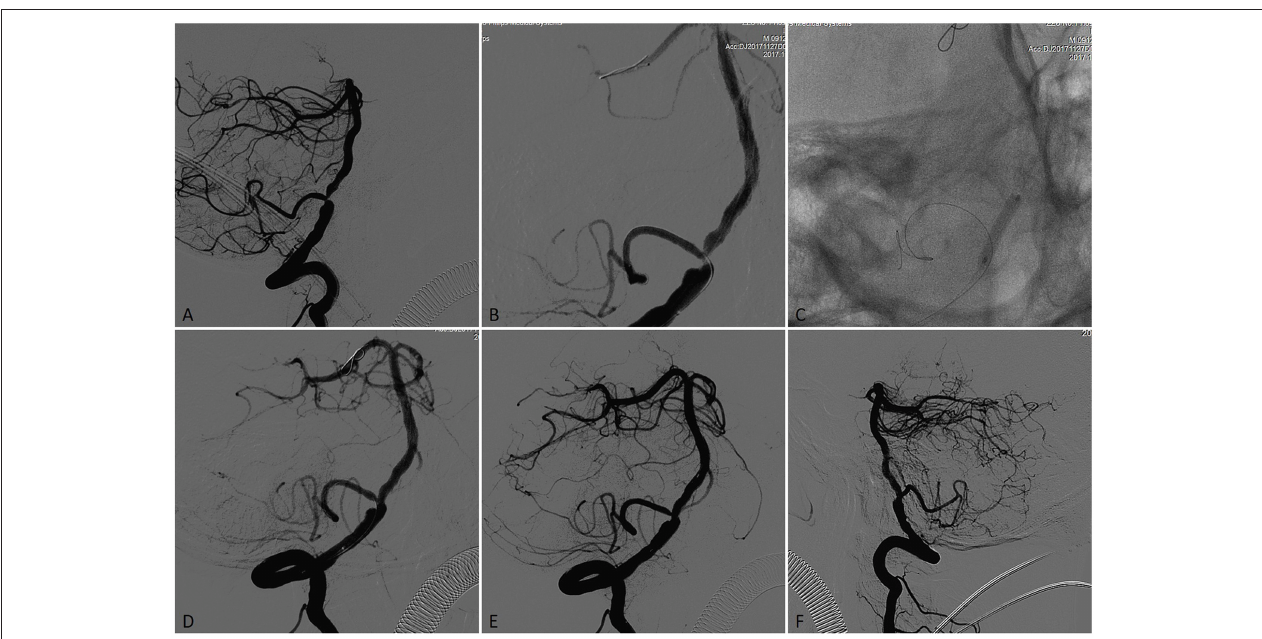
FIGURE 1 | A patient presented initially with recurrent posterior circulation territory TIAs on anti-platelet therapy, including diplopia. (A) Subtracted angiogram in the working angle demonstrated left vertebral artery occlusion and a concentric severe (75%) stenosis in the V4 segment of the right vertebral artery with the posterior inferior cerebellar artery (PICA) origin from the stenotic lesion. (B) A 0.008 inch microwire was placed in PICA aimed to protect it during the PTAS and a 0.014 inch microwire placed in P2 segment of right posterior cerebral artery (PCA) with the microwire tip manipulated a U- shaped loop inside the vessel. (C) The stenotic lesion was dilated with a 3.0 × 15-mm Gateway balloon. (D) Vertebral angiography showed significant improvement of the stenosis immediately after angioplasty. (E) Microcatheter angiography showed no vessel perforation, dissection and thrombus occurred in the distal artery where the microwire tip placed. (F) A 4.0 × 15-mm Neuroform EZ stent was deployed across the target lesion, Final angiography showed near 15% residual stenosis.